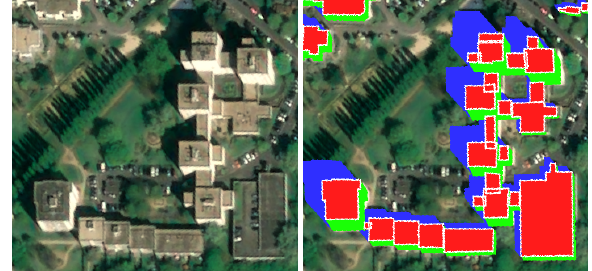
Figure 2. Example ground truth masks. Red: rooftops, green: facades, blue: shadows, white: